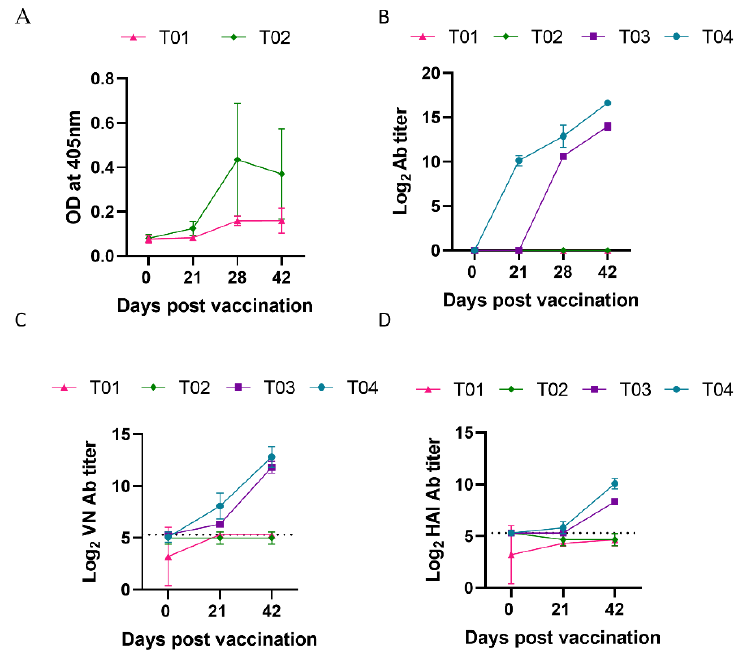
Figure 3. Humoral antibody responses post vaccination. ( A ) Anti-GFP antibodies in plasma samples from the T01 (PBS) and T02 (rPICV-GFP) groups. ( B ) Anti-H3 antibodies in plasma samples from all treatment groups. An arbitrary cutoff equivalent to mean plus 5 standard deviations of OD values of samples from the T01 and T02 groups was calculated. Samples with OD values greater than the cutoff were considered to be positive. The end-point antibody titers were expressed as the log 2 of the reciprocal of the highest plasma dilution that tested positive by the H3-specific ELISA. ( C ) Virus neutralization (VN) antibody titers against H3N2 TX98. ( D ) Hemagglutination inhibition antibody titers against H3N2 TX98. In ( C , D ), the horizontal dotted lines at 5.32 log2 (1:40 dilution) indicate the background antibody titers found in all pigs prior to vaccination. T01 — PBS; T02 — rPICV-GFP; T03 — rPICV-H3; T04 — H3-protein.